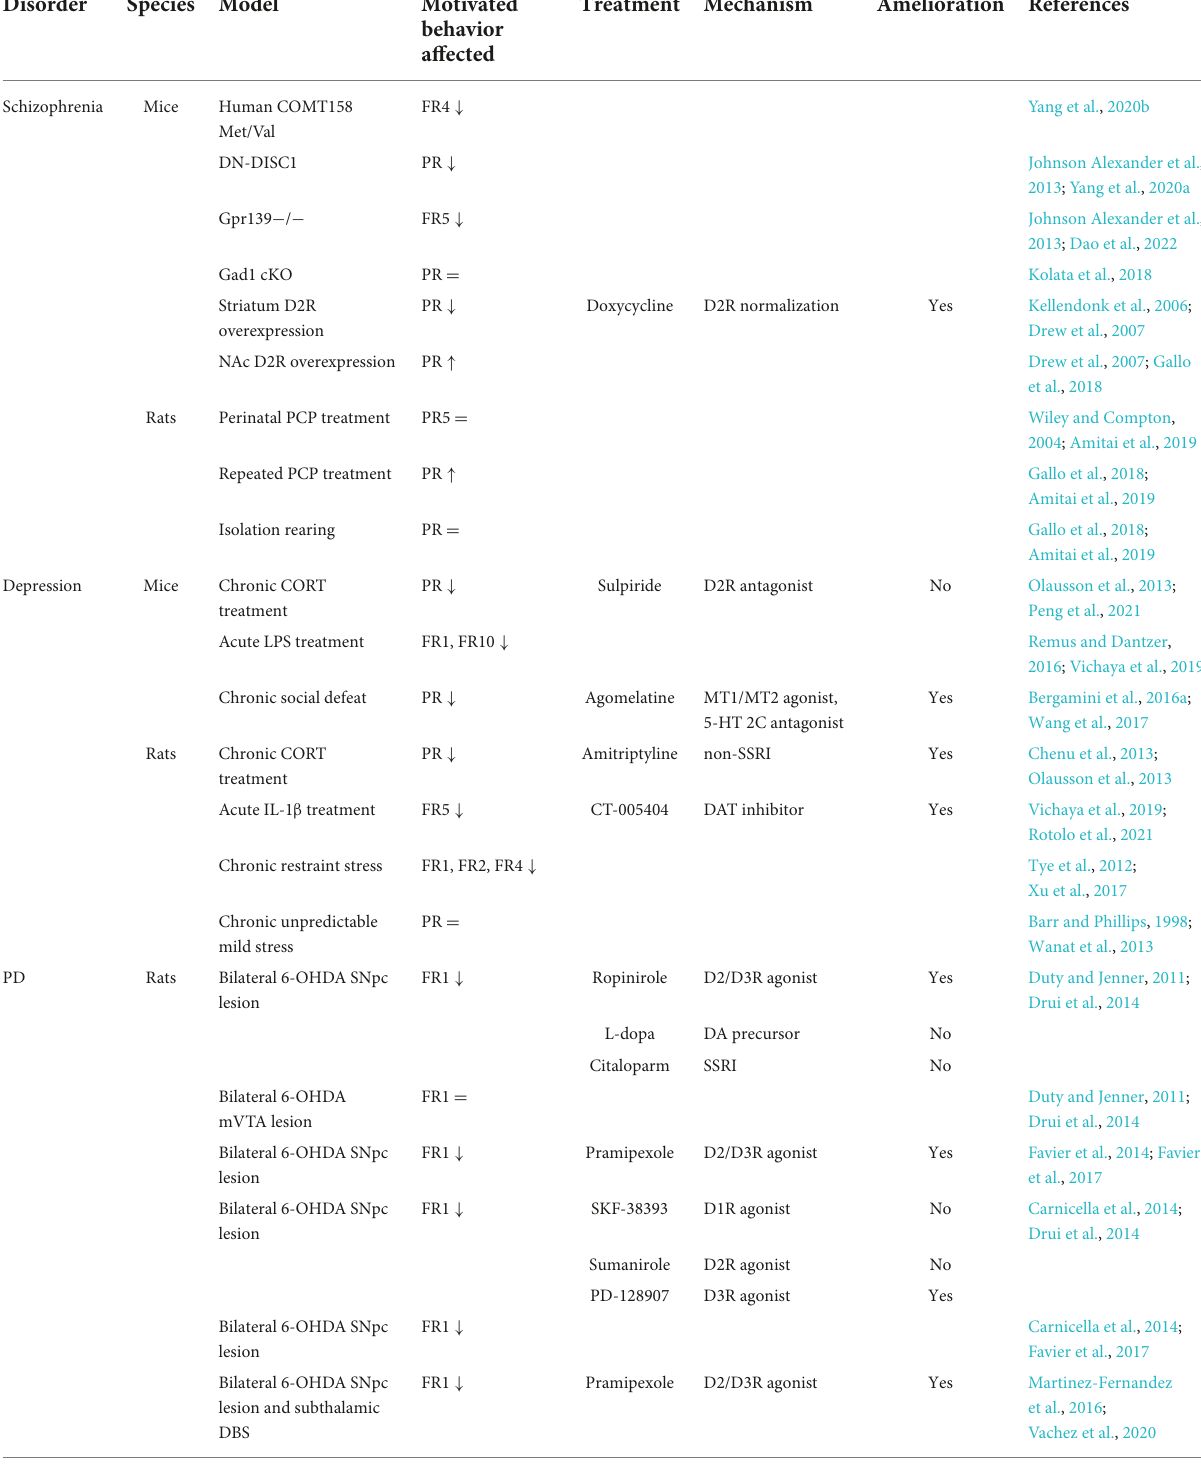
TABLE 1 Summary of the reviewed studies investigating motivation with operant conditioning tasks in rodent models of schizophrenia, depression, and PD, and the investigated pharmacological treatments to ameliorate motivation deficits.